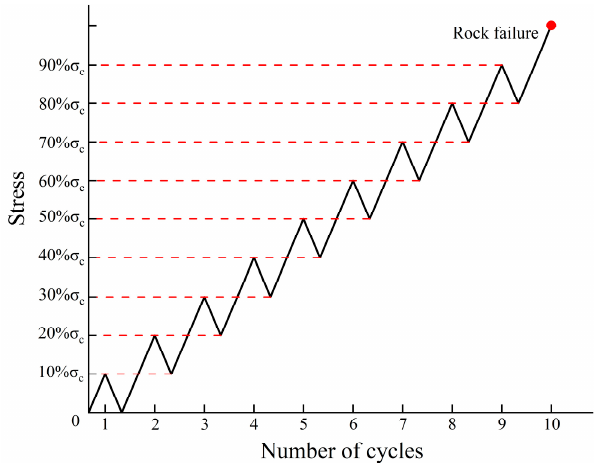
Figure 4. The stress path of variable lower limit cyclic loading and unloading (VLLCL).